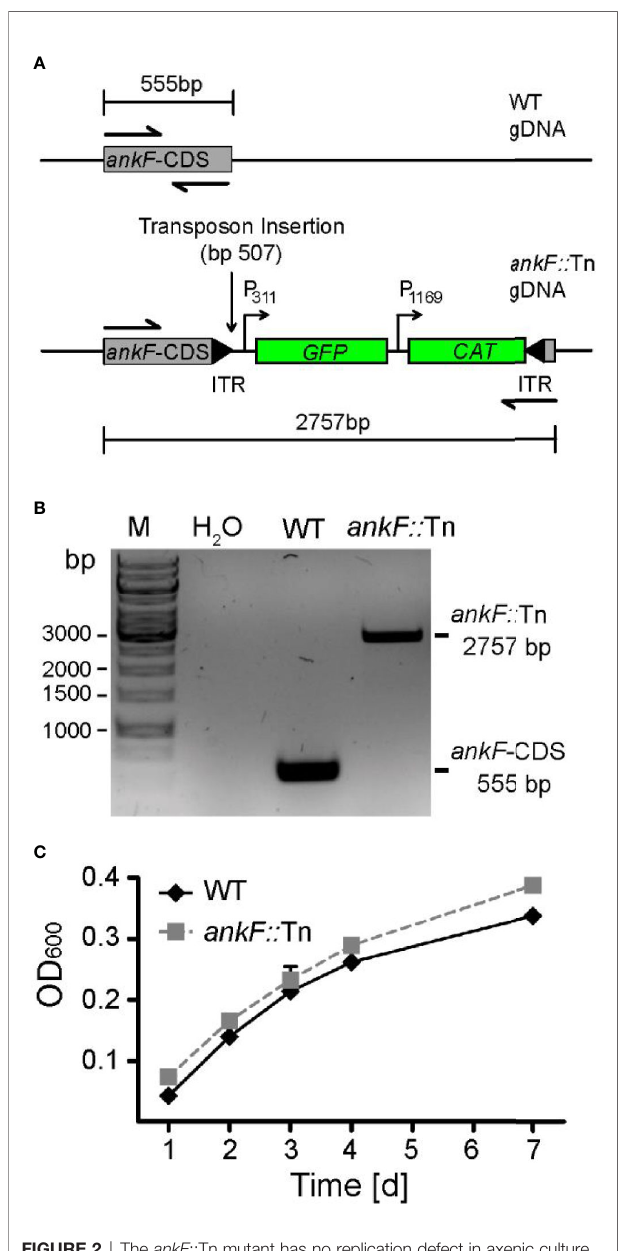
FIGURE 2 | The ankF ::Tn mutant has no replication defect in axenic culture. (A) Scheme of the genomic region of wild-type C. burnetii and C. burnetii - ankF ::Tn at the ankF locus. The transposable element is inserted between bp 507 and 508 of the ankF coding sequence and contains a GFP reporter under the control of the C. burnetii promotor P 311 and a chloramphenicol resistance cassette under the control of the C. burnetii promotor P 1169 . (B) Agarose gel of PCR products from wild-type C. burnetii and ankF ::Tn generated with primers speci fi c for the ankF coding sequence (shown as halved arrows in A). (C) Wild-type C. burnetii and ankF ::Tn were inoculated at an OD 600 of 0.01 in ACCM-2 medium and incubated at 37°C, 2.5% O 2 and 5% CO 2 . OD 600 was determined by spectrophotometric analysis at the indicated time-points post-inoculation. Error bars represent the mean standard deviation of three independent